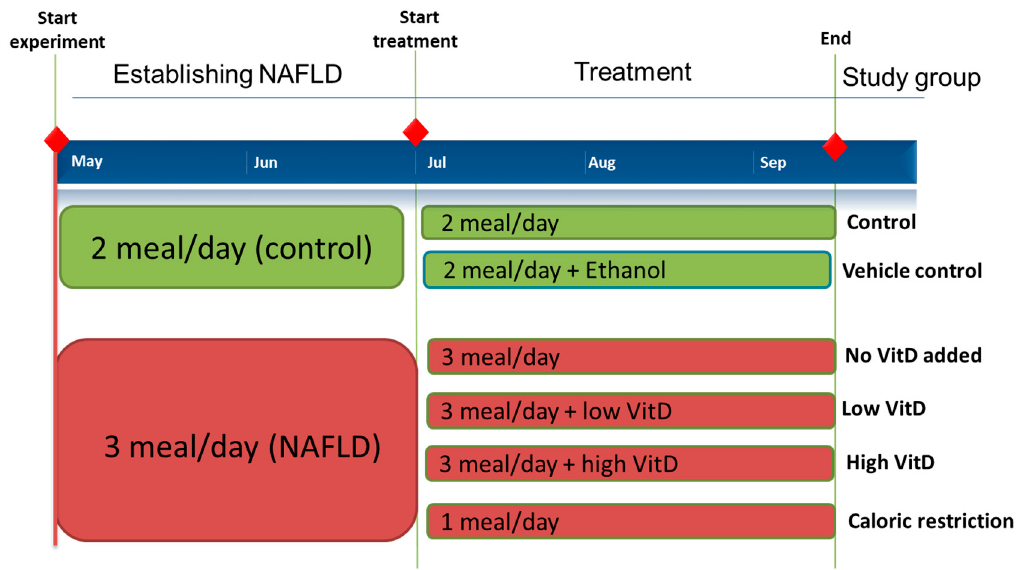
Figure 1. Diet and VitD supplementation effect on NAFLD in zebrafish: timeline of experiment. Establishing NAFLD in zebrafish was achieved by feeding 3 meals a day for 2 months while control group were fed twice a day. Afterwards, fish were divided into 6 study groups and treatment was applied for 3 months.